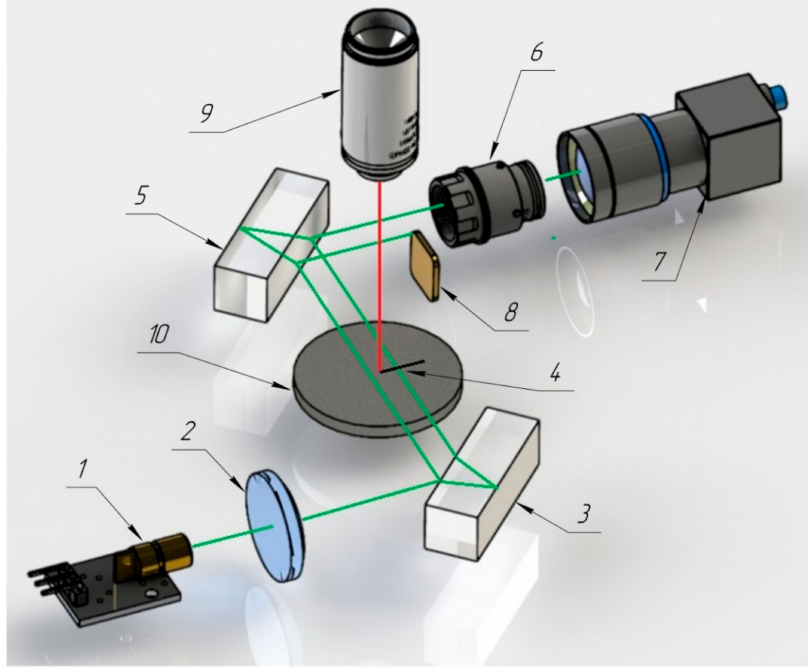
Figure 1. Experimental set-up: 1—probing laser; 2—lens; 3,5—plane-parallel glass